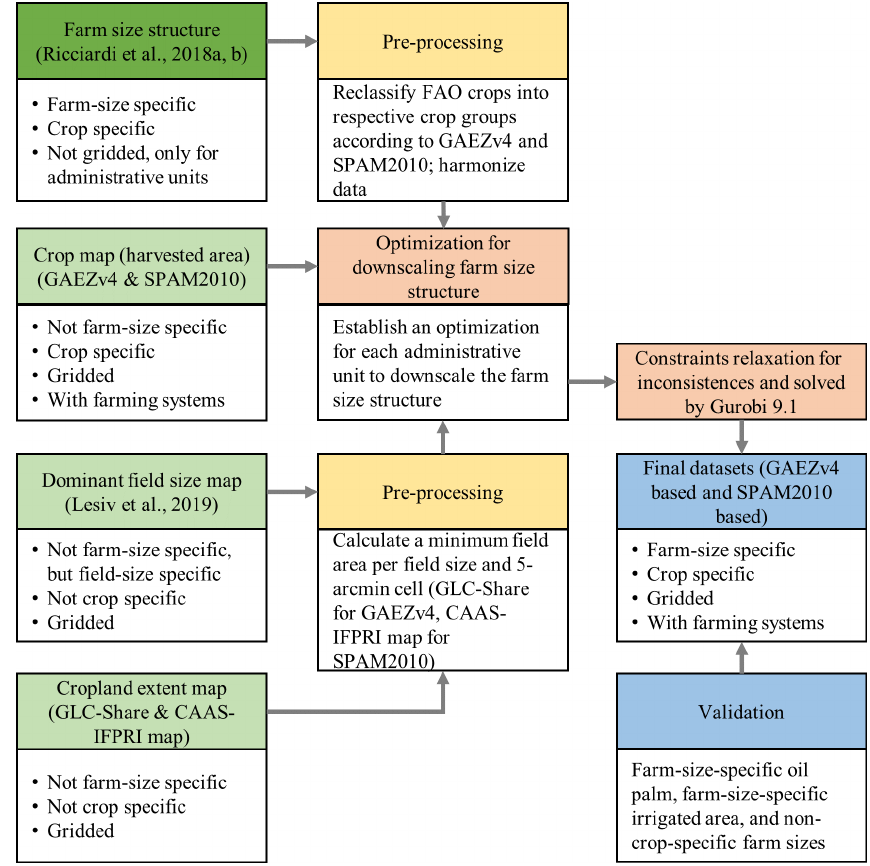
Figure 1. Diagram of dataset development processors.